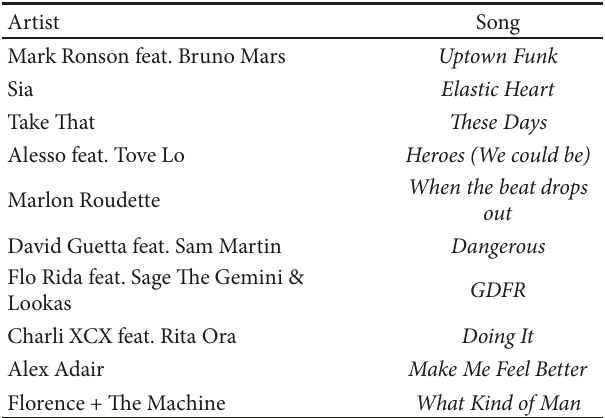
Table 1: Selected music tracks for perceptual